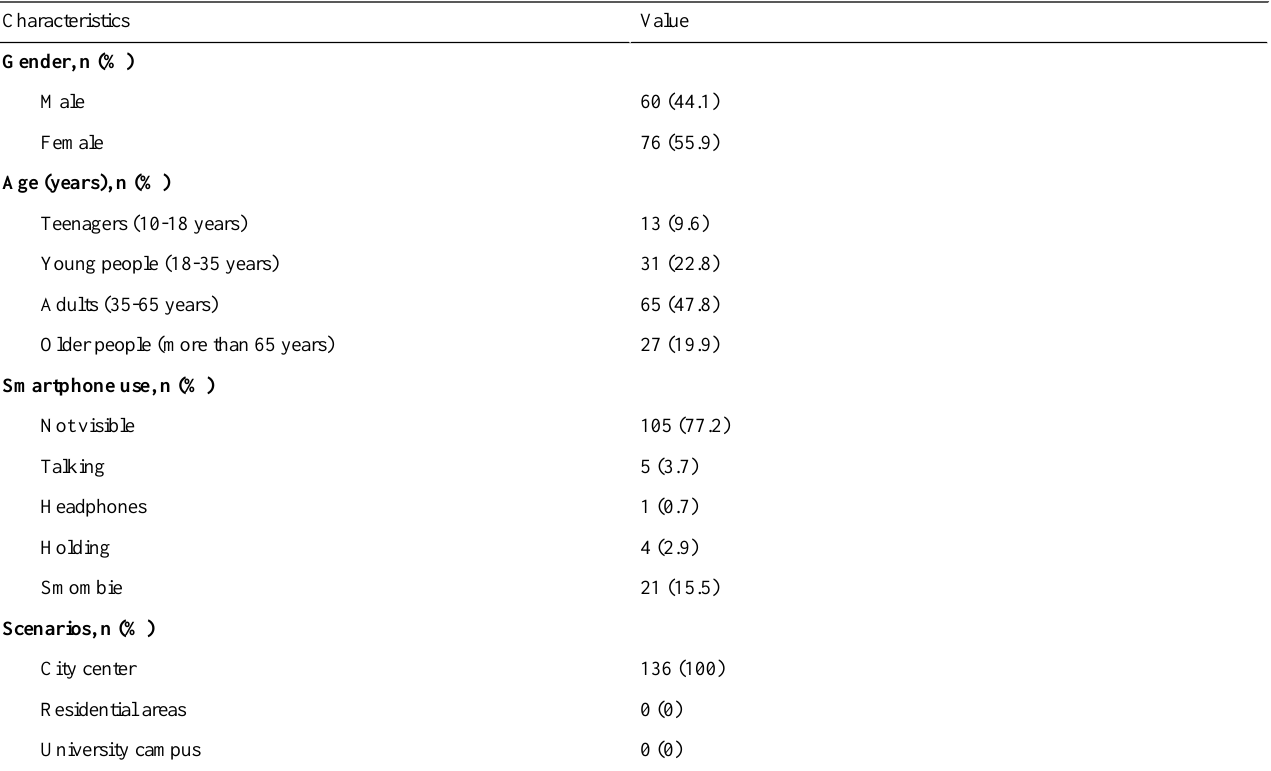
Table 9. Demographic characteristics of the observed pedestrians on the Pokemon Go Community Day